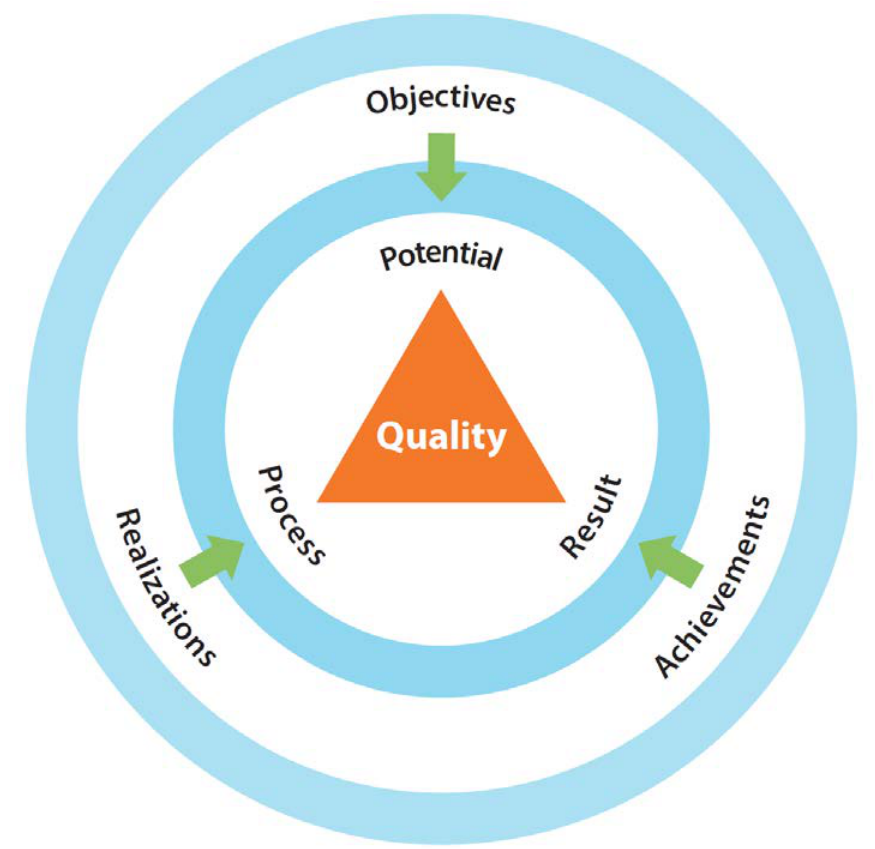
Figure 4 . Quality dimensions in Open